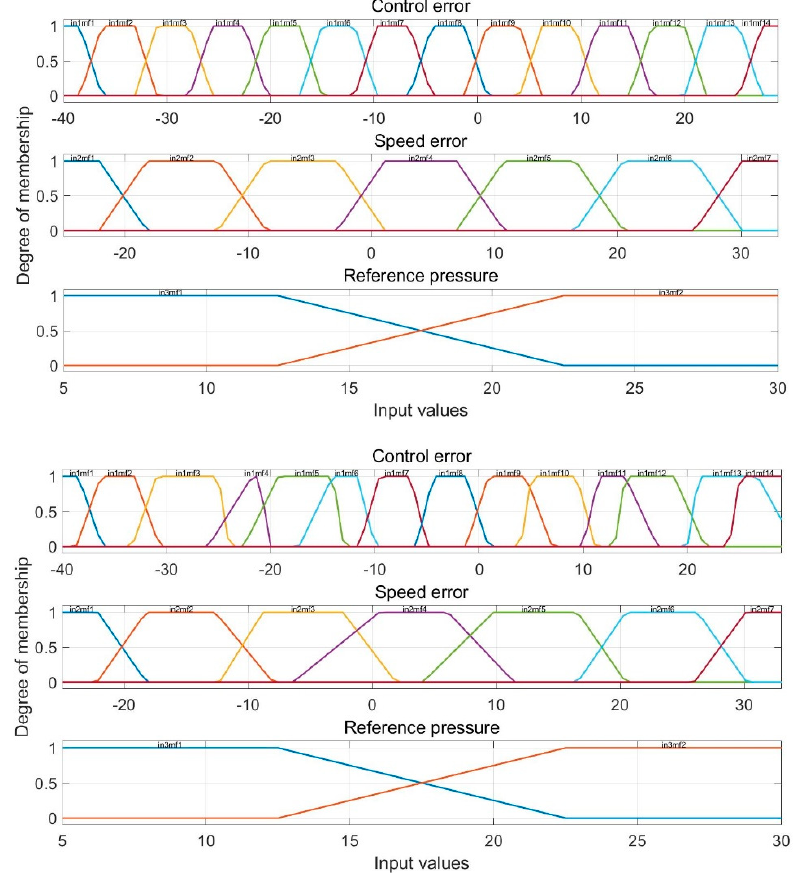
Figure 15. Membership functions of control error, speed error and reference pressure. Top: initial membership functions. Bottom: membership functions after training process.